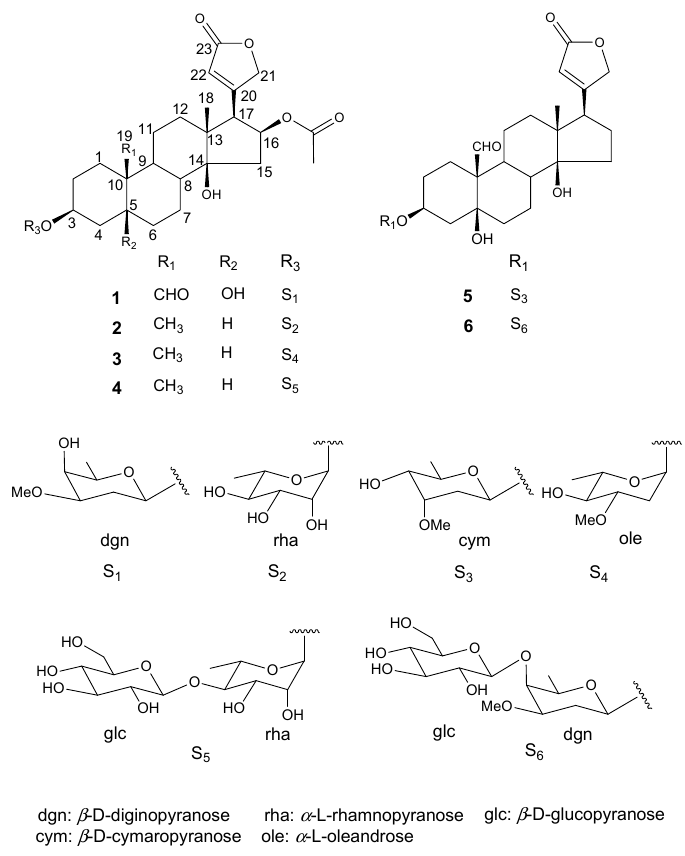
Figure 1. Compounds 1 – 6 isolated from the whole plants of Adonis multiflora .